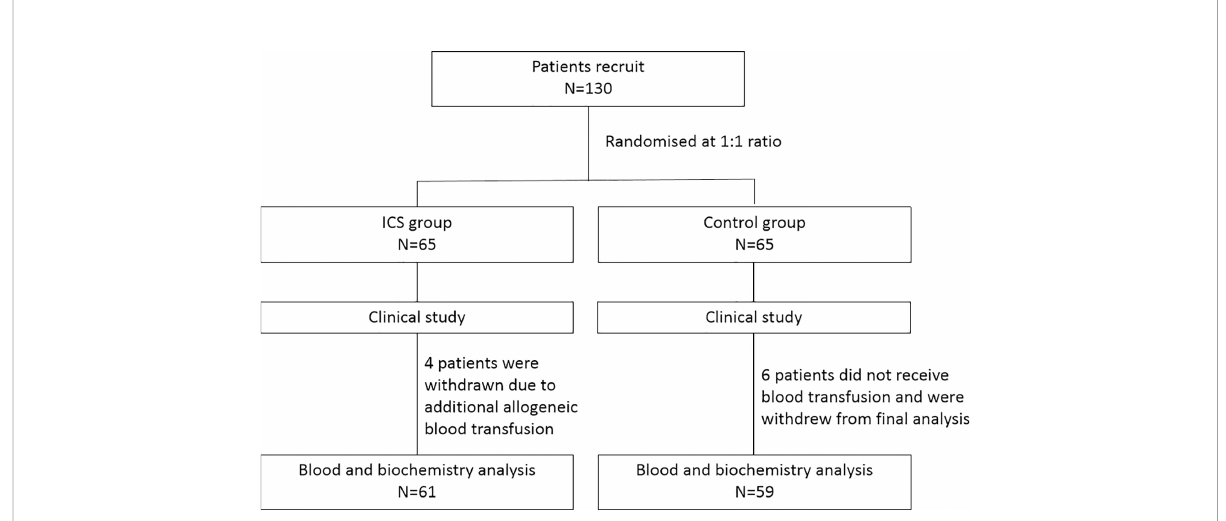
FIGURE 1 Flow diagram of the